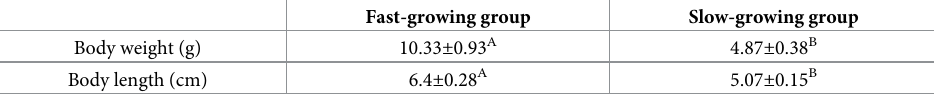
Table 1. Growth performance of 20 prawns between fast-growing and slow-growing